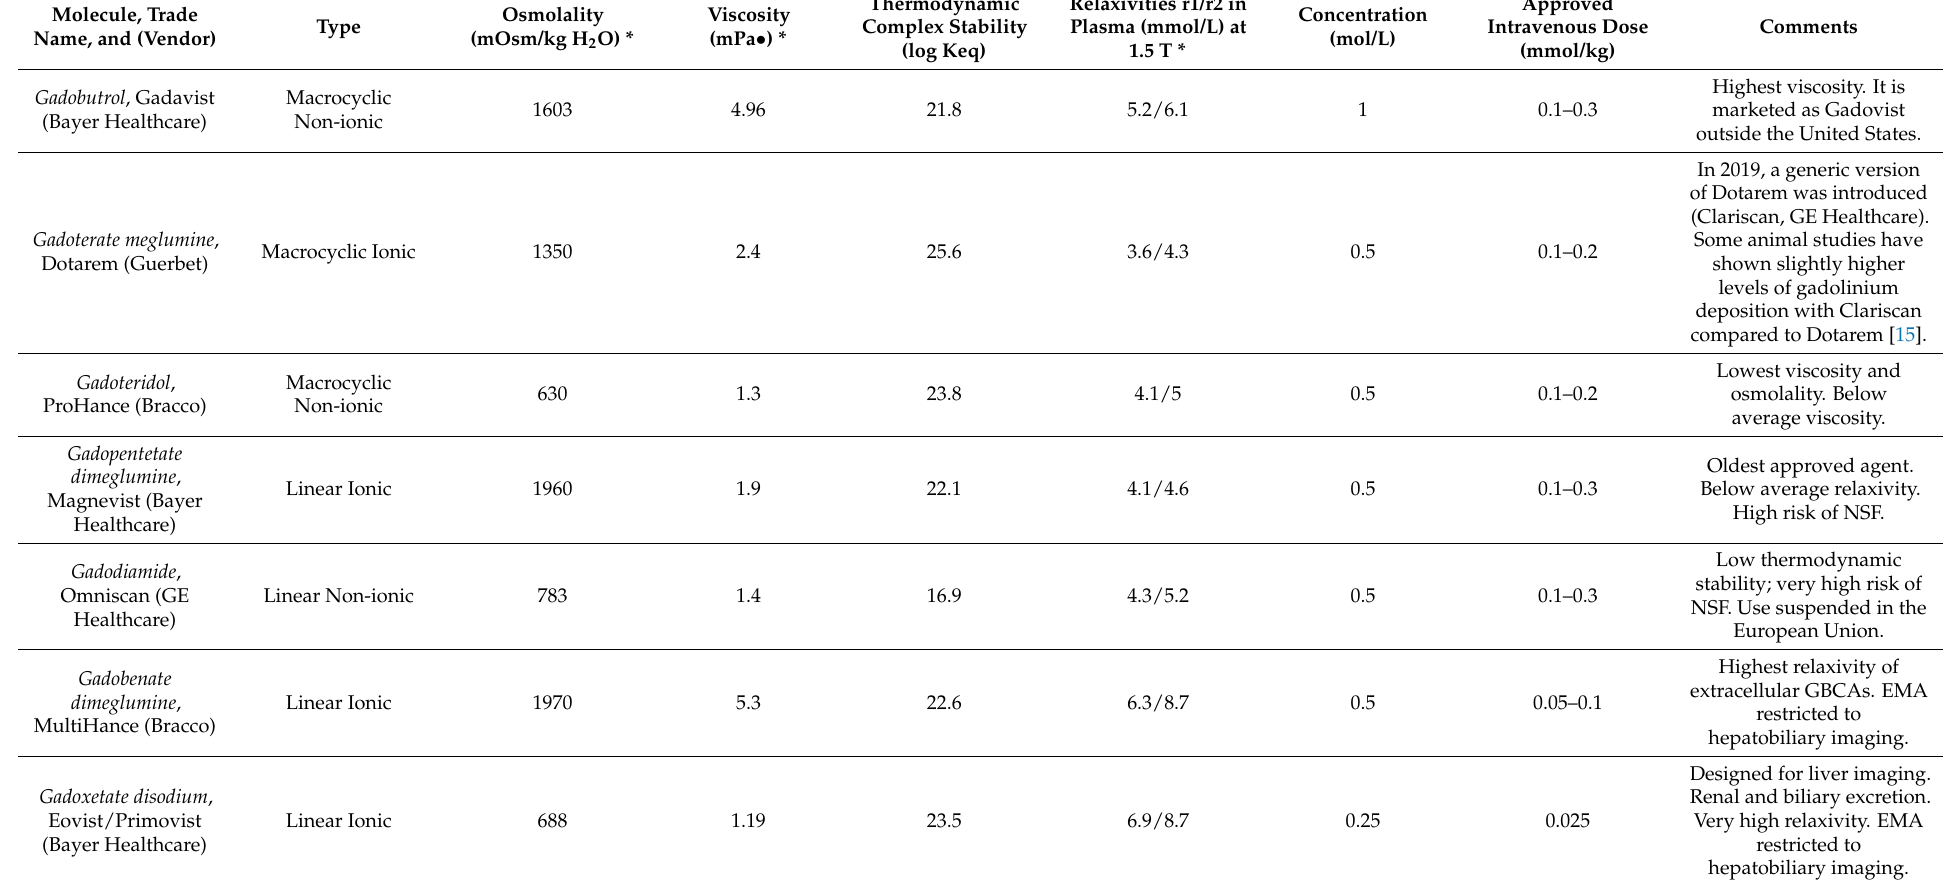
Table 1. Physicochemical characteristics of gadolinium-based contrast agents